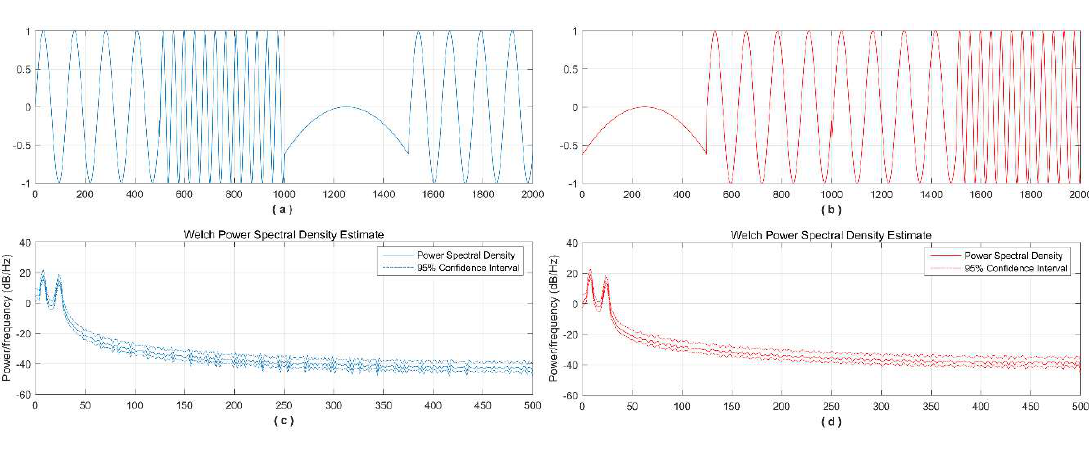
Figure 2. Time-frequency Distribution of Non-stationary Signals: ( a , b ) Two signals with frequency components that vary with time; ( c , e ) Welch power spectrum density estimation and time frequency distribution of the signal in ( a ); ( d , f ) Welch power spectrum density estimation and time frequency distribution of the signal in ( b